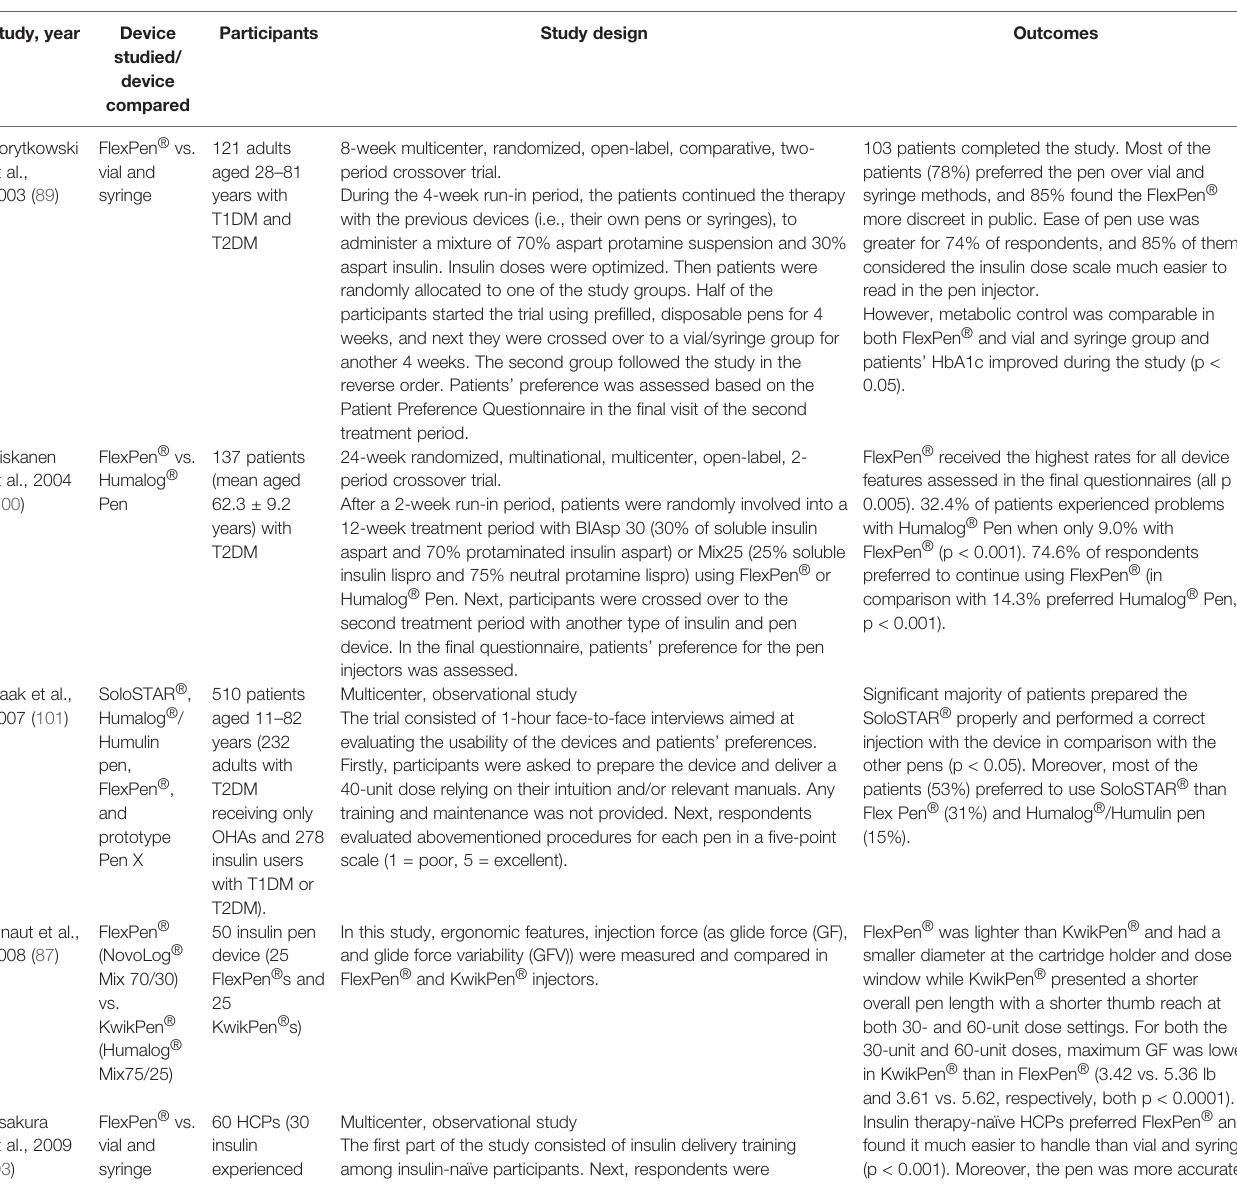
TABLE 3 | Pre fi lled insulin